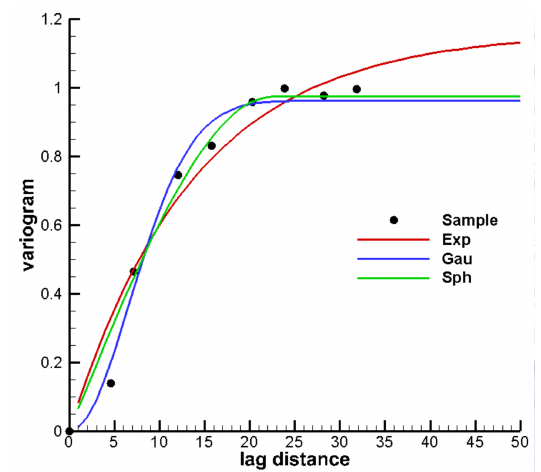
Figure 5. Results of variogram model calibrations against sample variogram. Solid lines denote the calibrated variogram model curves, and black dots represent the sample